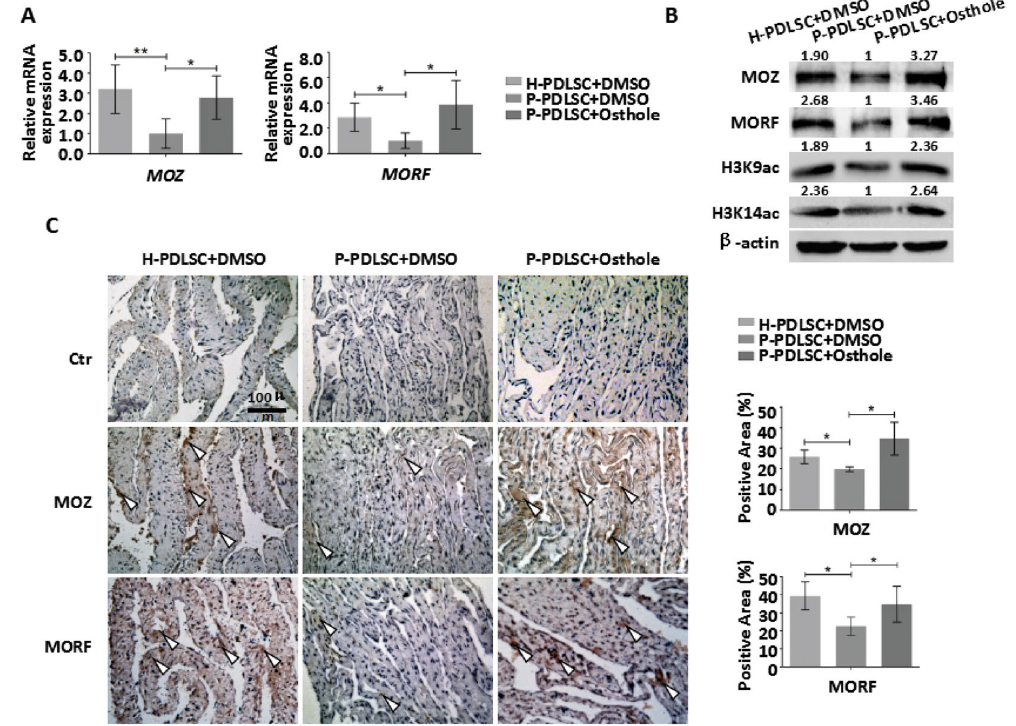
Figure 6. Expression of MOZ and MORF in PDLSC sheets with Osthole treatment. ( A ) Gene expression of MOZ and MORF in H-PDLSC sheet, P-PDLSC sheet and P-PDLSC sheet with 10 − 7 Mol/L Osthole. ( B ) Protein expression of MOZ, MORF, H3K9ac and H3K14ac in H-PDLSC sheet, P-PDLSC sheet and P-PDLSC sheet with 10 − 7 Mol/L Osthole. ( C ) Representative images of immunohistochemistry staining of MOZ and MORF in H-PDLSC sheet, P-PDLSC sheet and P-PDLSC sheet with 10 − 7 Mol/L Osthole. Semi-quantification of the positive area of MOZ and MORF was calculated. Scale Bar, 100 μ m. * P < 0.05, ** P < 0.01, n =